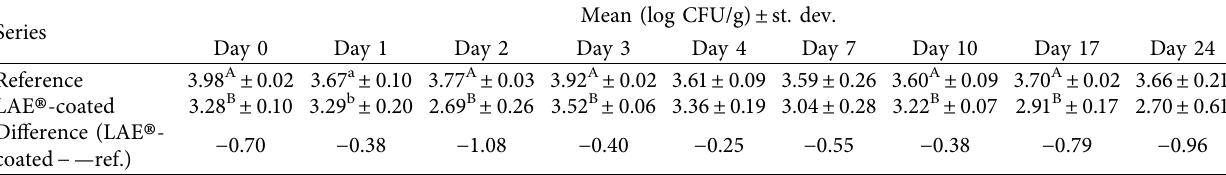
Mean (log CFU/g) ± st.